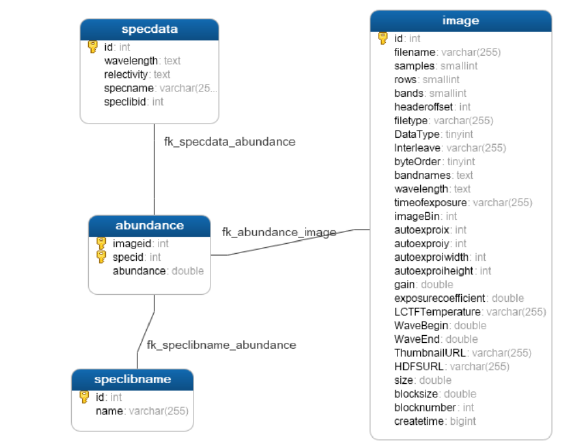
Figure 3. The main database tables relations for hyperspectral remote sensing images